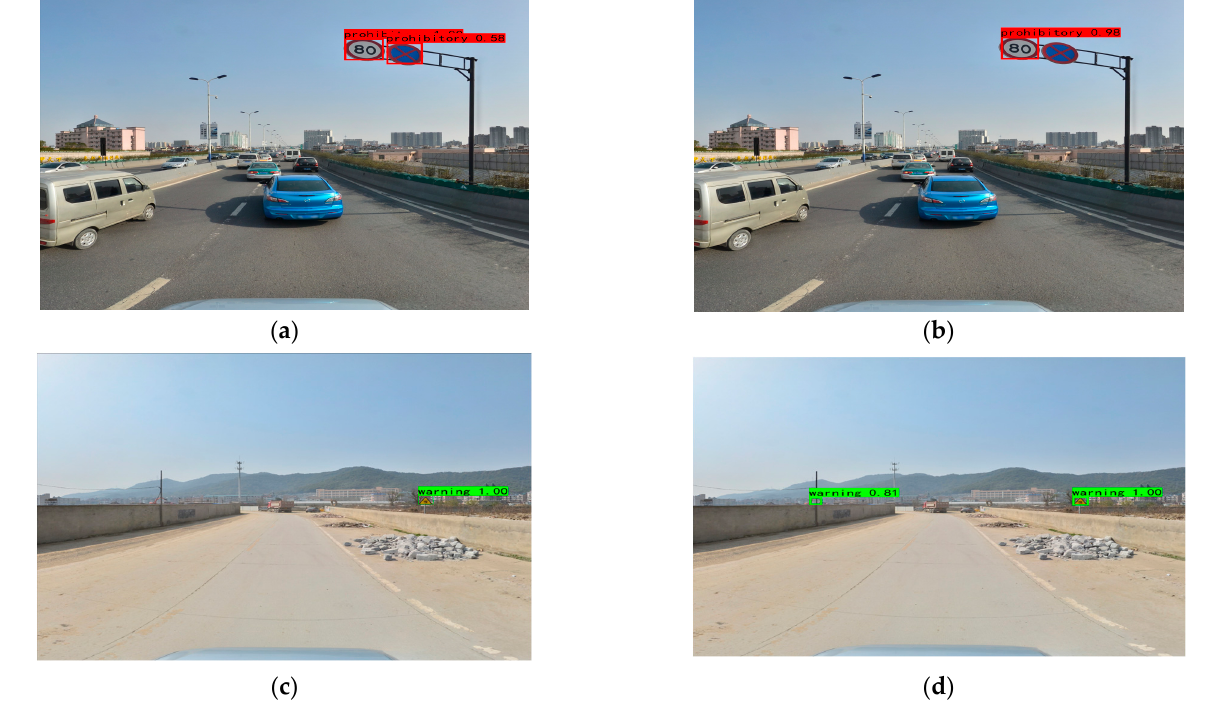
Figure 14. Comparison results of different algorithms in excellent lighting conditions, where ( a , c ) are the results of TSR-YOLO, ( b , d ) are the results of YOLOv4-tiny.